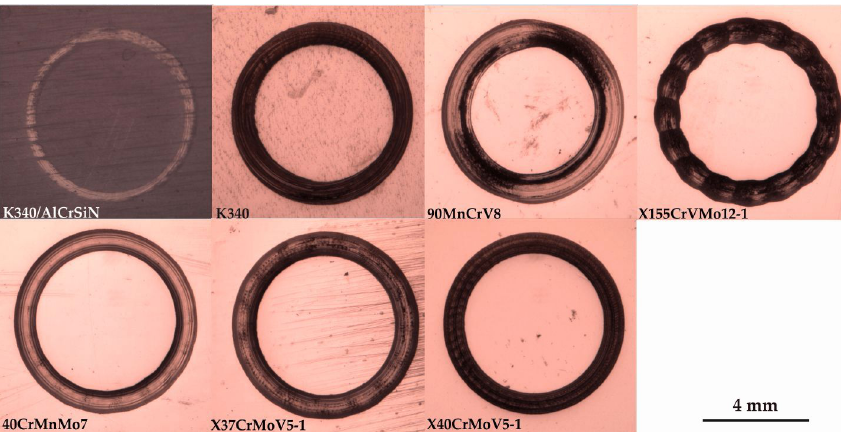
Figure 6. Worn surface of the samples tested under dry friction conditions.